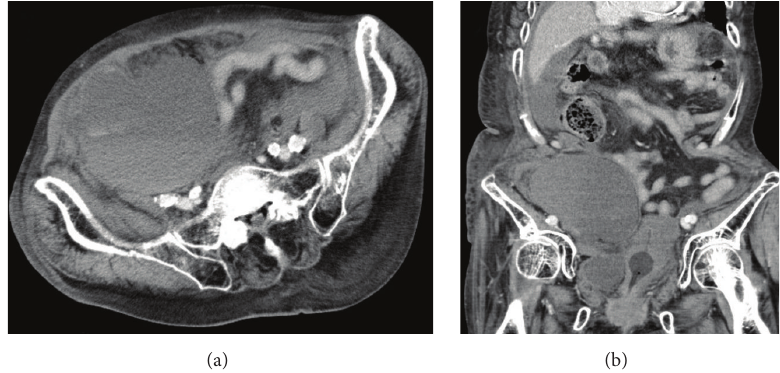
Figure 2: Abdominal computed tomography scans with intravenous contrast showing axial and coronal views. A massive preperitoneal hematoma is present beneath the right hypogastric vessels with hemoperitoneum.